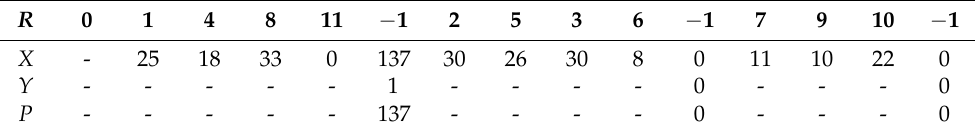
Table 2. Example of